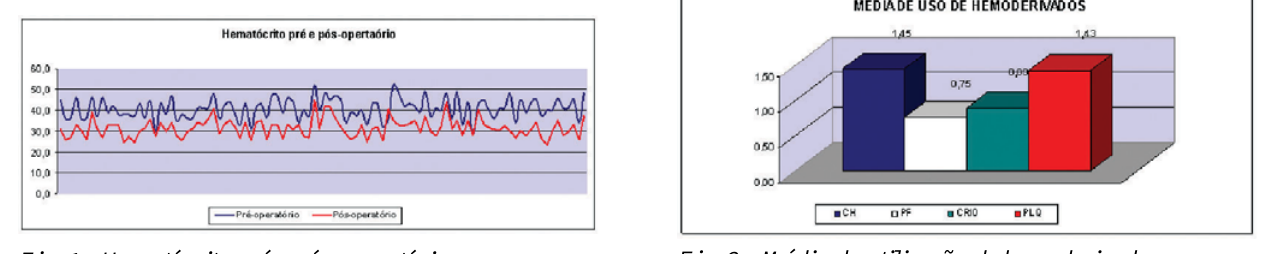
Fig. 1 - Hematócrito pré e pós-operatório Fig. 2 - Média de utilização de